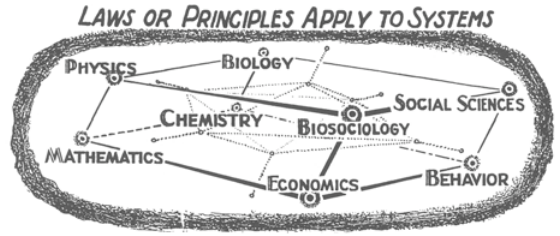
Fig. 2. Illustration of Bertalanffy’s General Systems